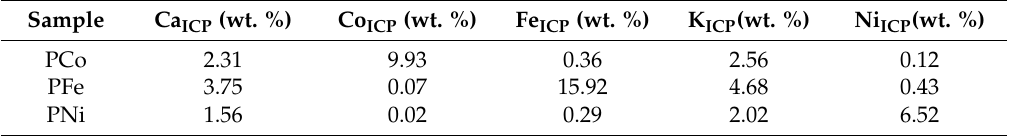
Table 2. Metal content of the composites determined by inductively coupled plasma optical emission spectrometry (ICP-OES).